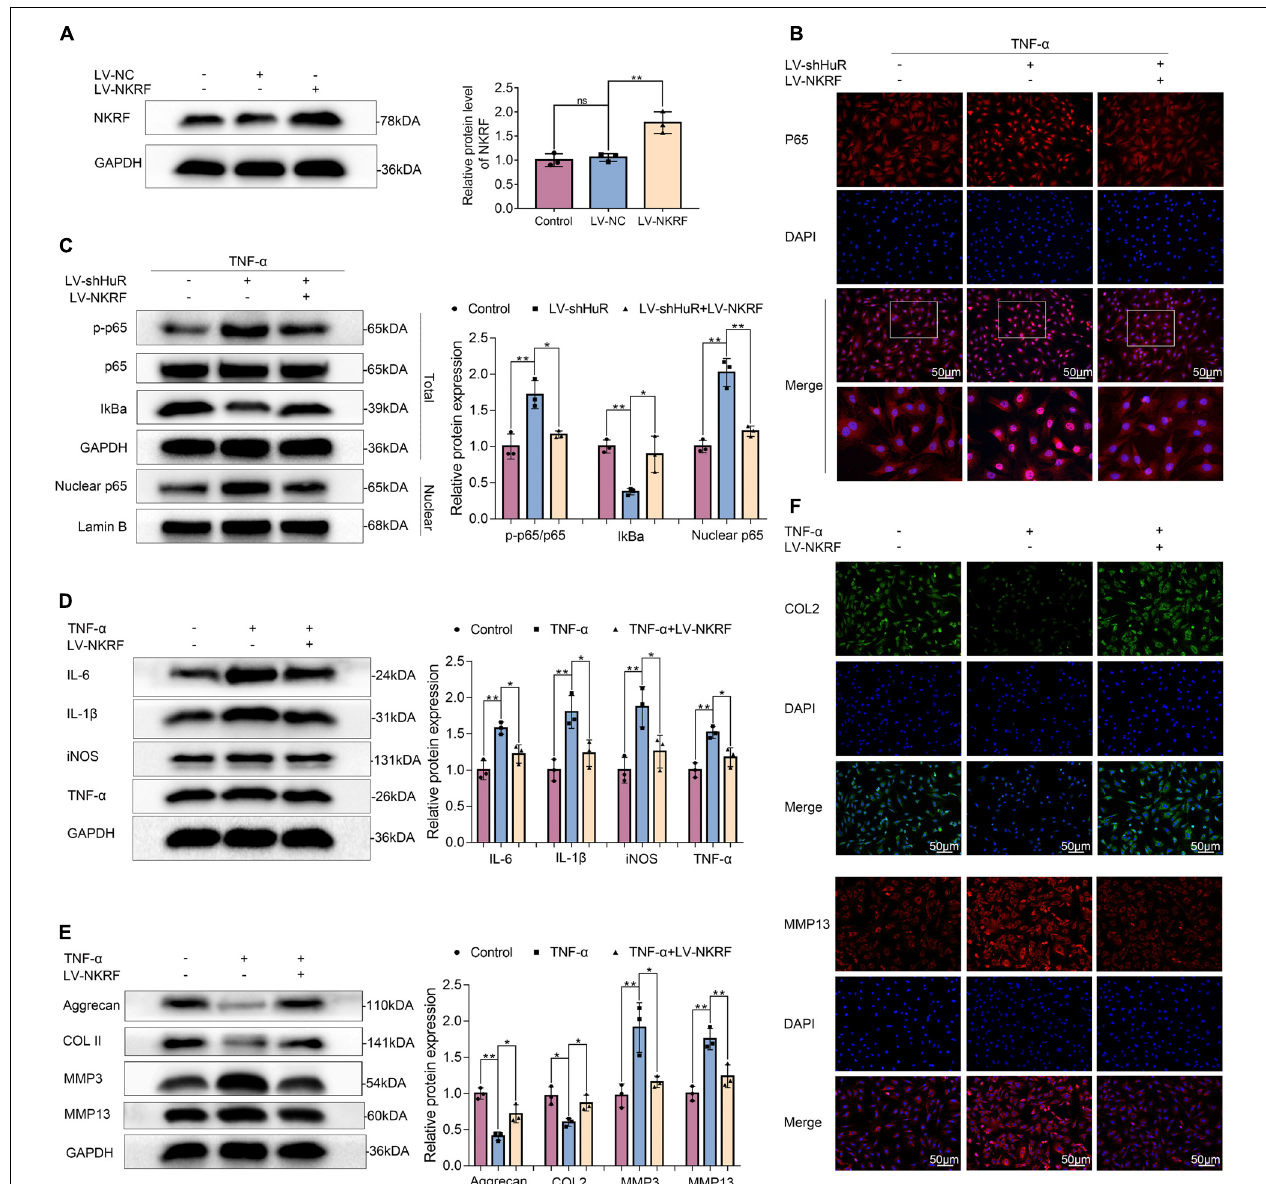
FIGURE 5 | NKRF regulates NF- κ B signaling pathway, inflammation, and ECM degradation in NP cells. The cells were transfected with LV-shHuR or LV-NKRF before TNF- α treatment. (A) The protein expression of NKRF was detected by Western blot in rat NP cells; the levels were determined using Image J software. (B) The p65 was detected by immunofluorescence combined with DAPI staining for nuclei (scale bar: 50 µ m). (C) The protein expression of p-p65, p65, I κ B α , and nucleus p65 was detected by Western blot in the NPCs, with or without added lentivirus. (D) The protein expression of IL-6, IL-1 β , TNF- α , and iNOS was detected by Western blot, with or without LV-NKRF lentivirus and TNF- α . (E) The protein expression of ECM biosynthesis and ECM breakdown proteins, such as Aggrecan, COL2, MMP3, and MMP13, with or without LV-NKRF lentivirus and TNF- α . (F) COL2 and MMP13 expressions were detected by immunofluorescence combined with DAPI staining for nuclei (scale bar: 50 µ m). All data were shown as mean ± SD ( n = 3) * p < 0.05, ** p < 0.01.